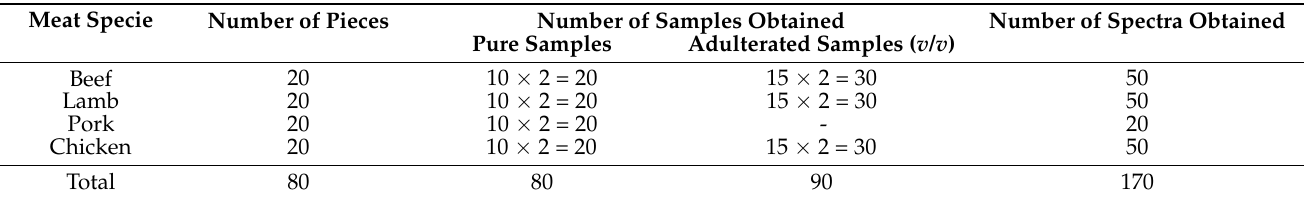
Table 2. Distribution of adulterated and pure samples along with the number of pieces produced and spectra obtained for individual